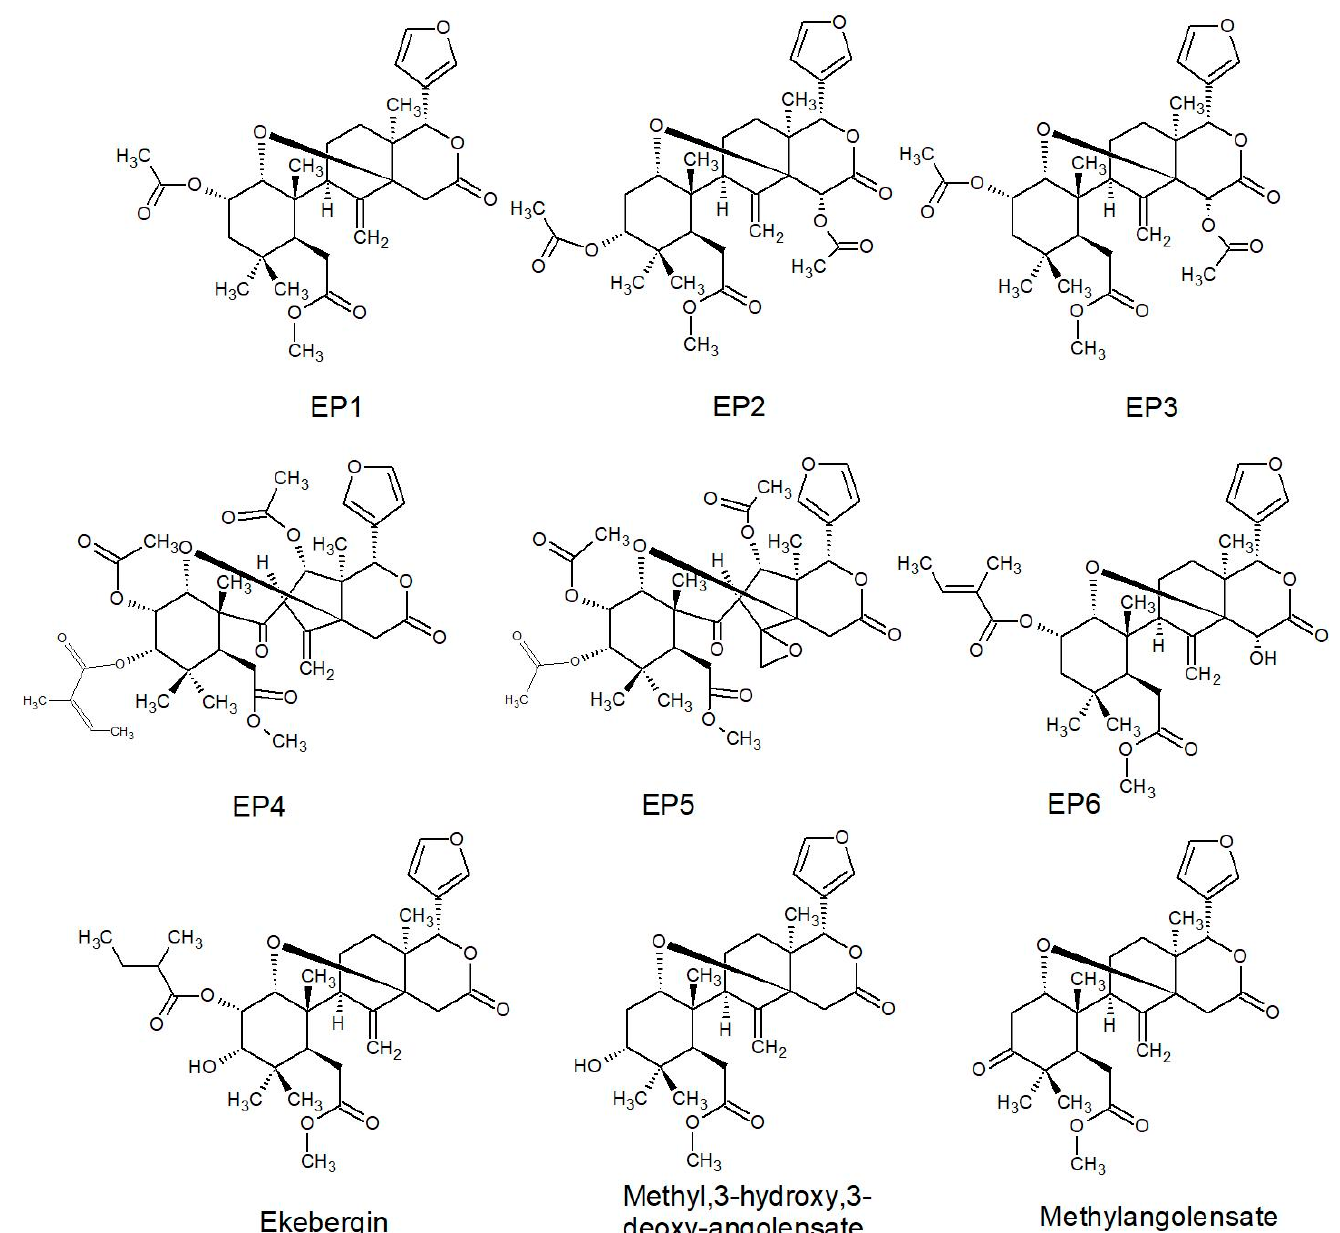
Figure 9. EP series of limonoids reported from South African Meliaceae [33,108,110,111].